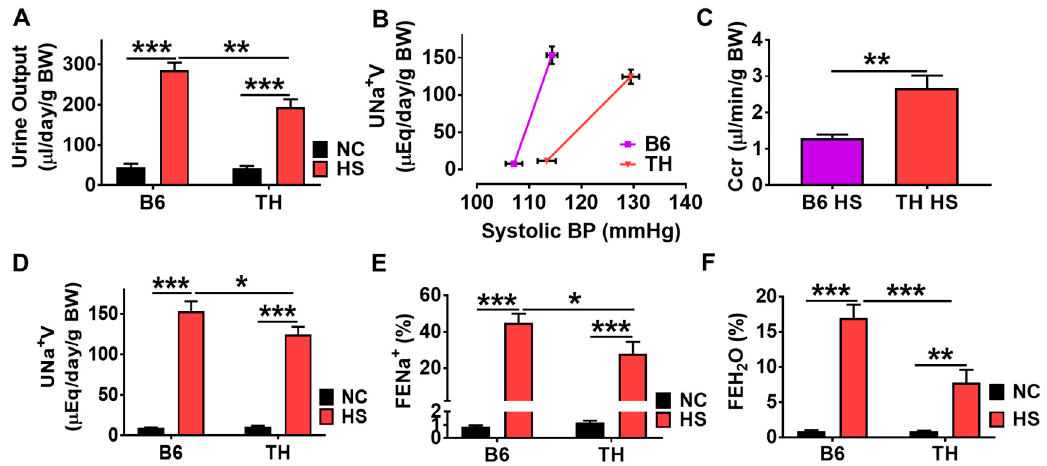
Figure 4. TH mice encounter blunted renal Na + excretion. ( A ) Urine output ( n = 8–10). ( B ) Pressure-natriuresis curve was plotted with systolic BP on the abscissa and the total Na + excretion on the ordinate ( n = 7–9). ( C ) Creatinine clearance (Ccr, n = 7–9). ( D ) Total Na + excretion rate ( n = 6–7). ( E ) Fractional Na + excretion ( n = 8–10). ( F ) Fraction water excretion ( n = 7–9). Results in A–F, * p < 0.05; **